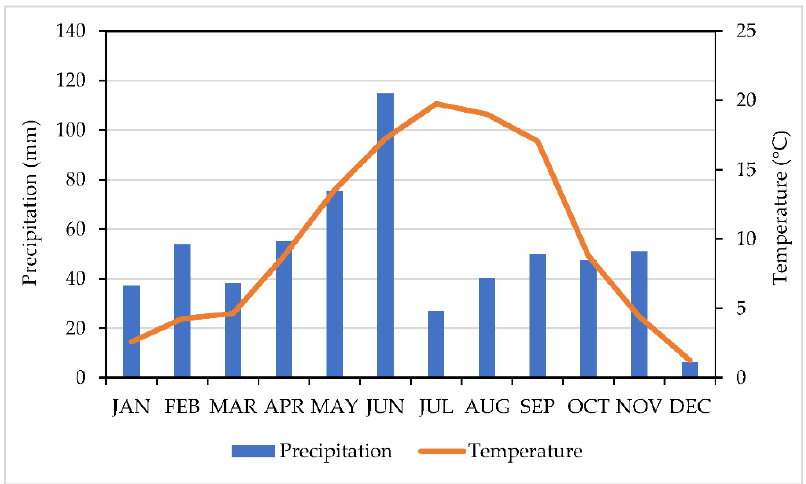
Figure 2. Overview of monthly precipitation and monthly average temperature conditions at the field trial site (407 m AMSL, N 48°42 ′ 57.024 ″ , O 9°12 ′ 52.956 ″ ) in the year of harvest (2016).